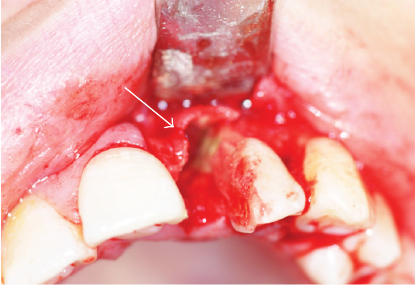
Figure 8: Postoperative radiograph: the defect left by the extraction of the mesial tooth is sealed with MTA.